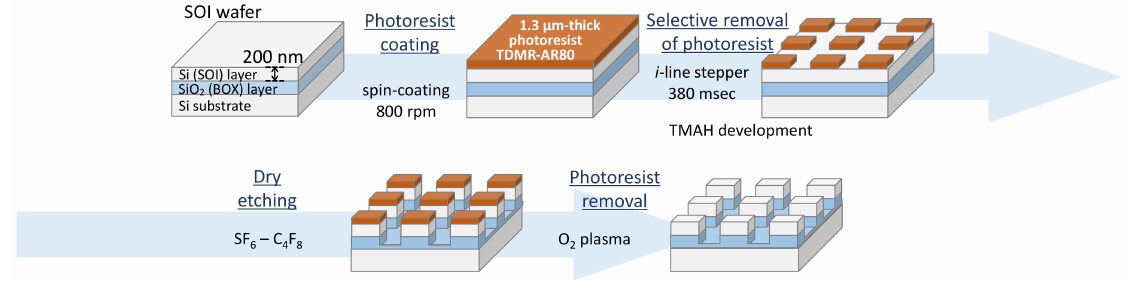
Figure 2. Schematic flow diagram of the fabrication process of the releaser. For the receiver, after being cleaned in the same manner as the SOI wafer, the SiO 2 - topped Si wafer was spin-coated with a photoresist film (TCIR-ZR8800, Tokyo Ohka Kogyo Corp., Tokyo, Japan) of a thickness of 3.6 µ m with a rotation velocity of 2900 rpm. After the same soft baking as that for the SOI wafer, the SiO 2 -topped Si wafer with the photoresist was exposed in the same manner for 300 msec, followed by a development by TMAH aq. The areal region of the SiO 2 -topped Si wafer not covered by the photoresist was dry-etched by CHF 3 and C 4 F 8 to a depth of approximately 2 µ m, to the exposure of Si substrate underneath the SiO 2 layer. The residual photoresist on the SiO 2 -topped Si wafer was removed by a dip in acetone with ultrasonication. Figure 3b,c present a bird’s-eye-view and cross-sectional scanning electron microscope images of the receiver piece with an SiO 2 terrace,